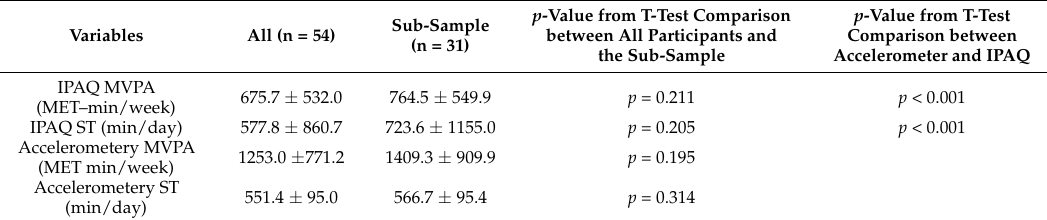
Table 4. Comparison of International Physical Activity Questionnaire (IPAQ) and accelerometry-derived moderate-to-vigorous intensity physical activity and sedentary time for the 54 participants with valid data, and the 31 participants who participated in qualitative interviews. Data are mean ± standard deviation.